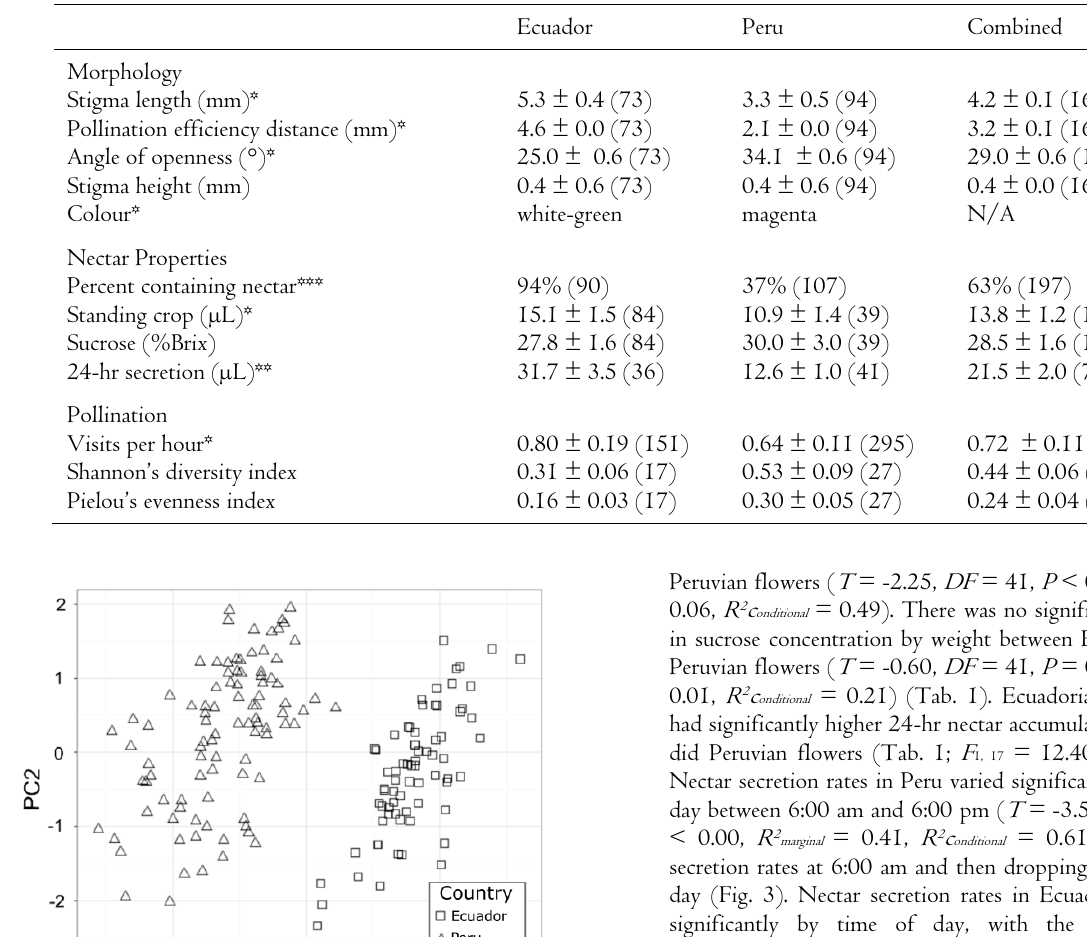
T ABLE 1. Summary of floral traits and pollination ecology of O. grandiflora in southern Ecuador and northern Peru. Mean values with standard errors for Ecuadorian and Peruvian populations of O. grandiflora and the combination of both. Asterix (*) indicates significant differences between the Ecuadorian and Peruvian populations < 0.05, ** indicates P-values < 0.01, *** indicates P -values less than 0.001. Numbers within parentheses represent sample sizes.